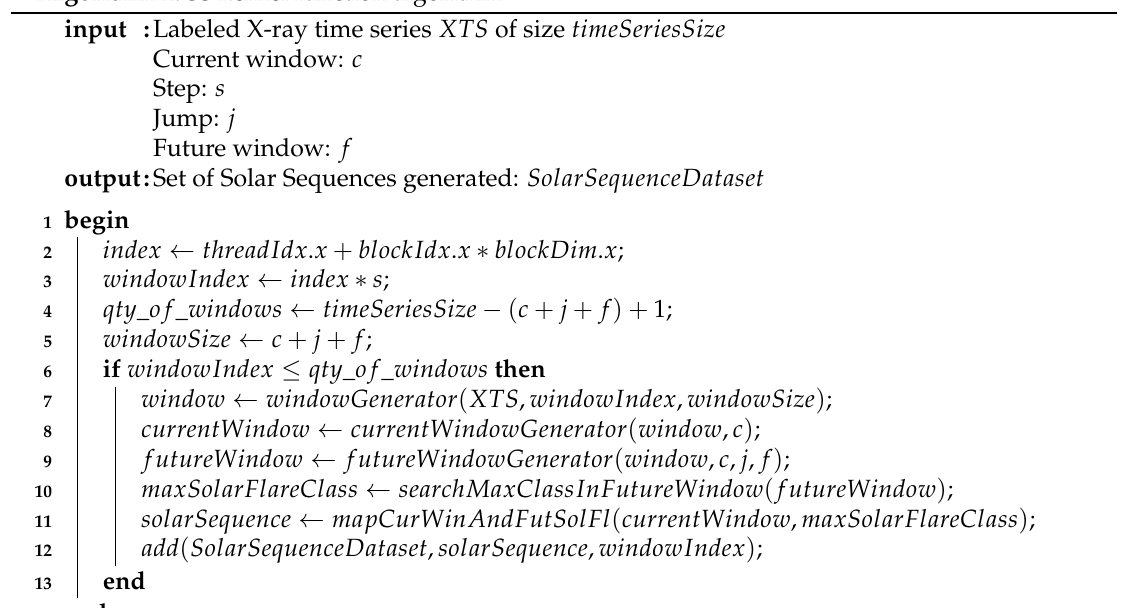
Algorithm 2: SS kernel function